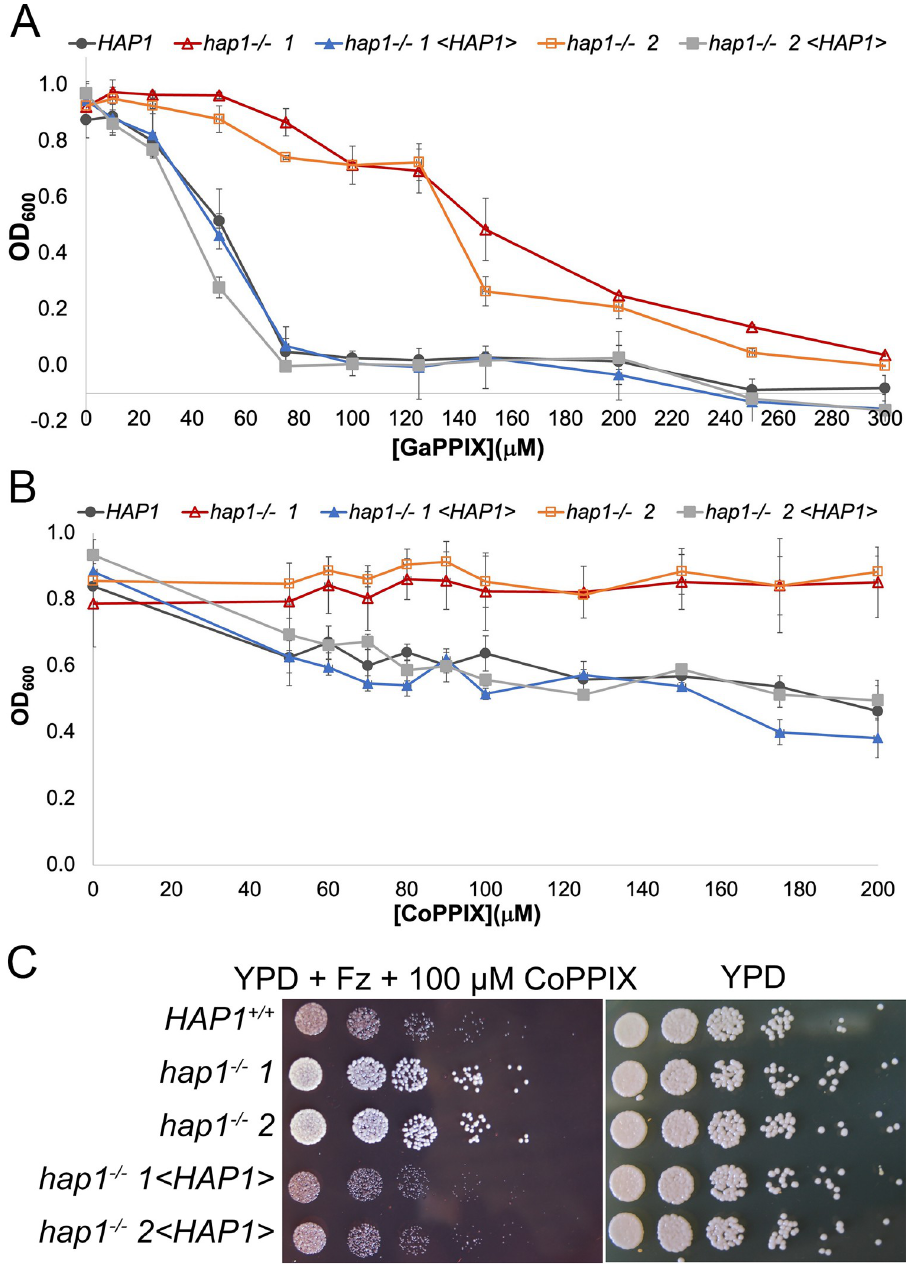
Fig 1. The hap1 -/- mutant is resistant to the heme analogs GaPPIX and CoPPIX. (A) GaPPIX MIC (minimal inhibitory concentration) assay of the wild-type (KC1266), two independent hap1 -/- deletion strains (KC1408) and the reintegrated strains (KC1407). The indicated strains were inoculated in triplicate with the indicated GaPPIX concentrations in 96 well plates, in YPD + 1 mM ferrozine to induce the heme-uptake genes, and incubated for 2 days at 30˚C. The graph indicates the average density for each triplicate, and the error bars indicate the standard deviations. (B) CoPPIX MIC assay of the same strains as in A. (C) Drop dilution assay of the same strains, inoculated on YPD medium supplemented with 1 mM ferrozine and 0.1 mM CoPPIX, vs. a YPD control plate. The Petri plates were incubated at 30˚C for two days.